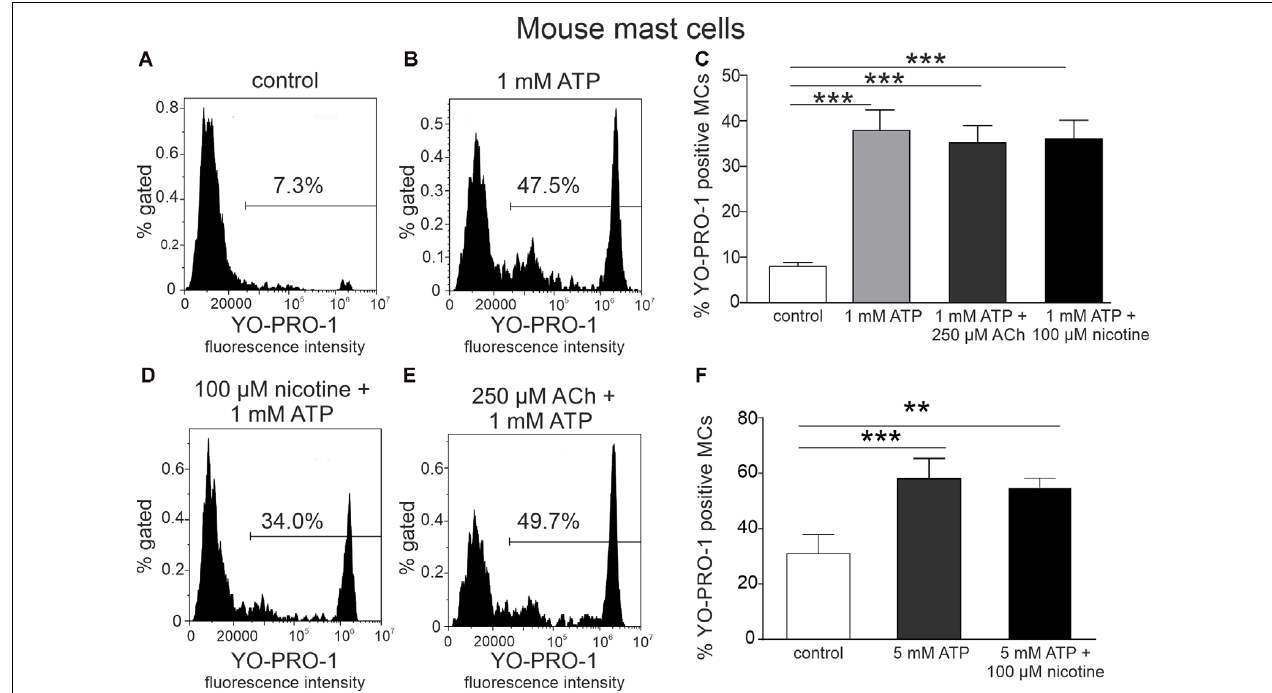
FIGURE 2 | Acethylcholine and nicotine do not affect ATP-stimulated YO-PRO1 uptake. (A,B,D,E) Representative histograms (fluorescence intensity vs. percent of gated mast cells) of YO-PRO1 uptake by mast cells. (A) Negative control (cells treated with PBS), mouse peritoneal mast cells incubated with 1 µ M of YO-PRO1. (B) Mast cells incubated with 1 mM of ATP. (D) Mast cells preincubated with 100 µ M nicotine followed by stimulation with 1 mM ATP. (E) Mast cells preincubated with 250 µ M acetylcholine followed by stimulation with 1 mM ATP. (C) Histograms showing percent of YO-PRO1-positive cells in control (white, n = 12), after stimulation with 1 mM ATP (light gray, n = 12) alone, and in the presence of 250 µ M acetylcholine (dark gray, n = 12) or 100 µ M nicotine (black, n = 12). (F) Histograms showing percent of YO-PRO1-positive cells in control (white, n = 3), after stimulation with 5 mM ATP (gray, n = 3) alone, and in the presence of 100 µ M nicotine (black, n = 12). Mean ± SEM, ** p < 0.01, *** p < 0.001 vs. control (one-way ANOVA, followed by Bonfferoni’s multiple comparison